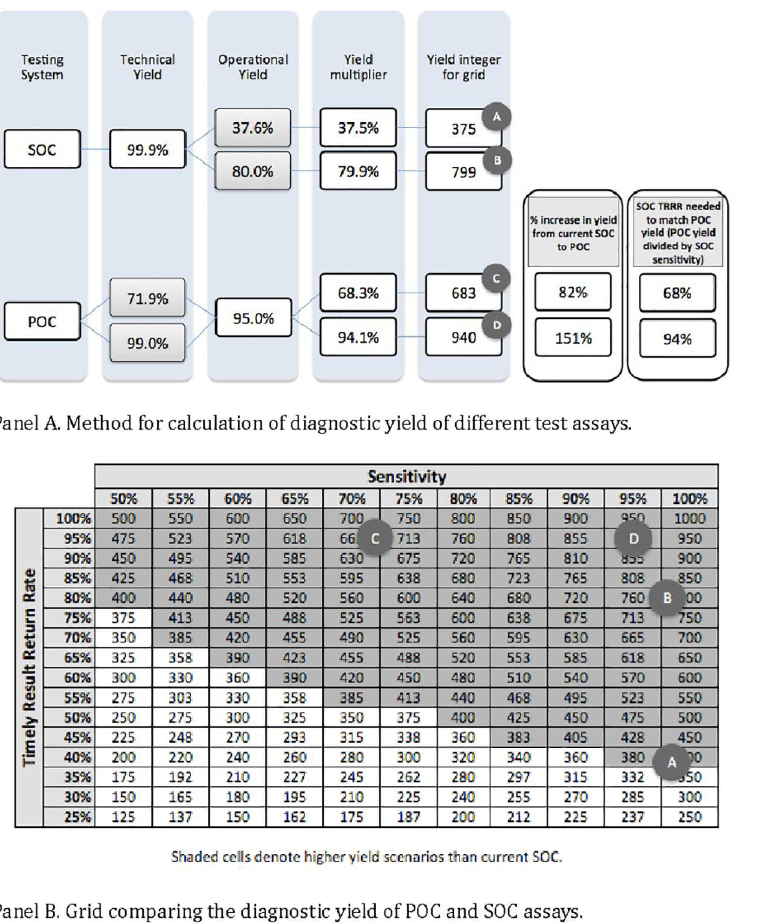
Fig 2. Comparing Technologies for Potential Patient